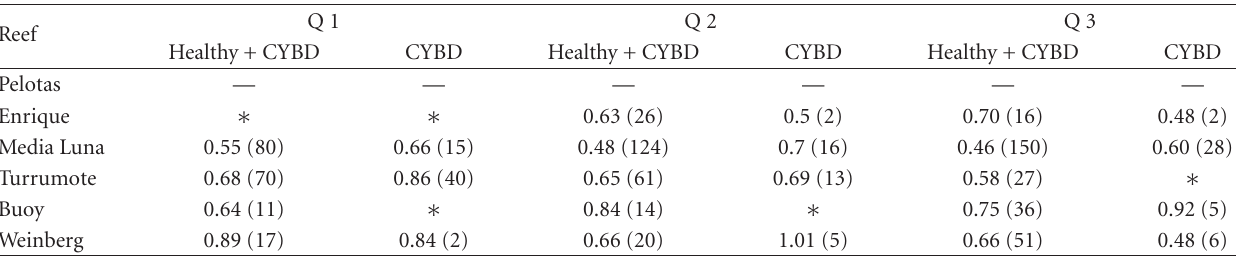
Table 3: Index of aggregation, R values, with sample size (in parenthesis) for the three 100m 2 quadrants (Q) in the di ff erent sites. (—): no data was found. ( ∗ ): not significant data. Q 1 Reef Pelotas — — — — — — Enrique ∗ ∗ Media Luna Turrumote Buoy Weinberg